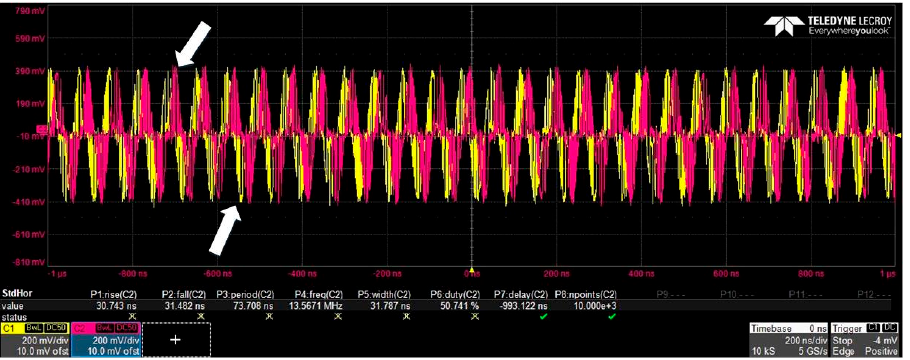
Figure 5. I and Q signals of coherent OOK (down arrow indicates to I-channel signal, up arrow indicates Q-channel signal). indicates Q-channel signal).